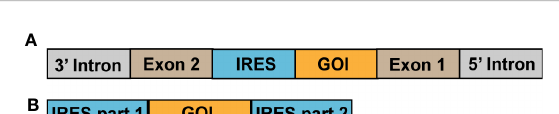
FIGURE 3 Methods currently used to formulate circRNA vaccines. (A) Circularization by intron splicing; (B) Ligation by T4 RNA ligase. GOI, gene of